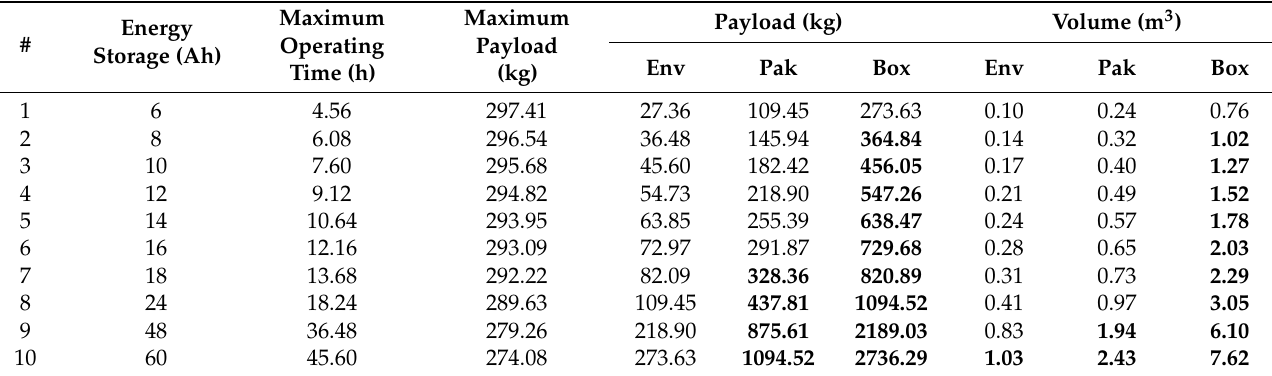
Table 2. Total cost corresponding to the vehicle configurations (bold values indicate non-admissible solutions exceeding the maximum allowed payload of 300 kg or the maximum volume of 1 m 3 ).